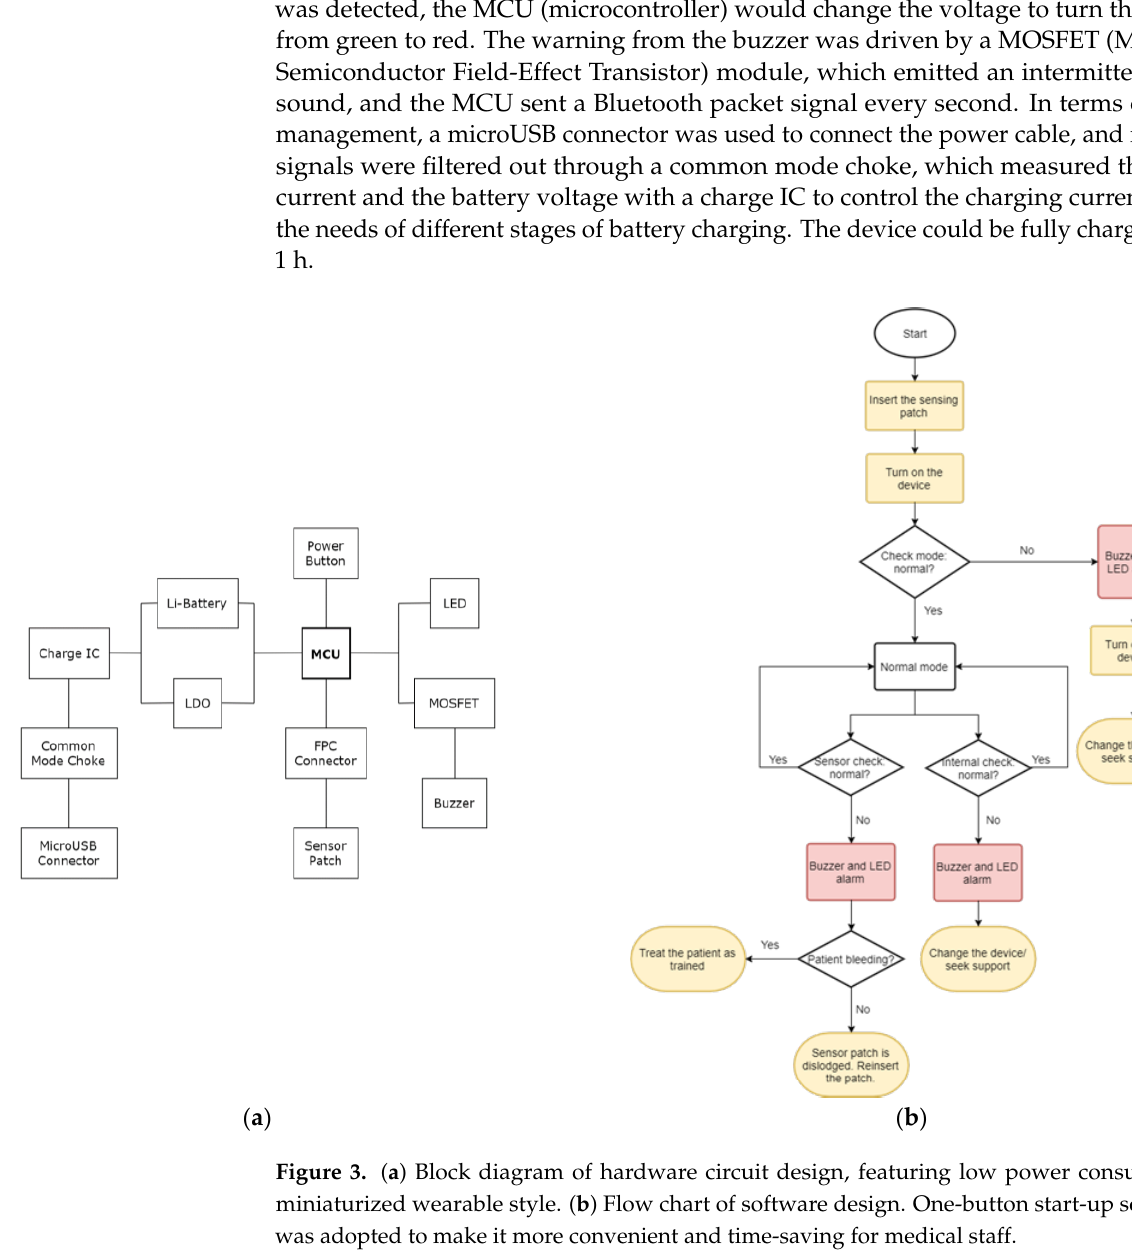
Figure 4. ( a ) Temporal profile of the voltage of the detection patch after injecting a single bolus of pig blood. Yellow line: the voltage from the detection patch. Cyan clusters of spikes: warning buzz- ers. Red dotted line: the saturation voltage. ( b ) The directions of blood ejection. A – E in ( b ) are 5 directions. Two sets of simulation were conducted to evaluate the performance of the sensor. In the first set, the blood was released in five directions (Figure 4b) to test whether the sensor was equally sensitive to all directions. The second set was designed to test the sensitivity of the sensor to the flow rates (1 – 5 mL/s) of blood.